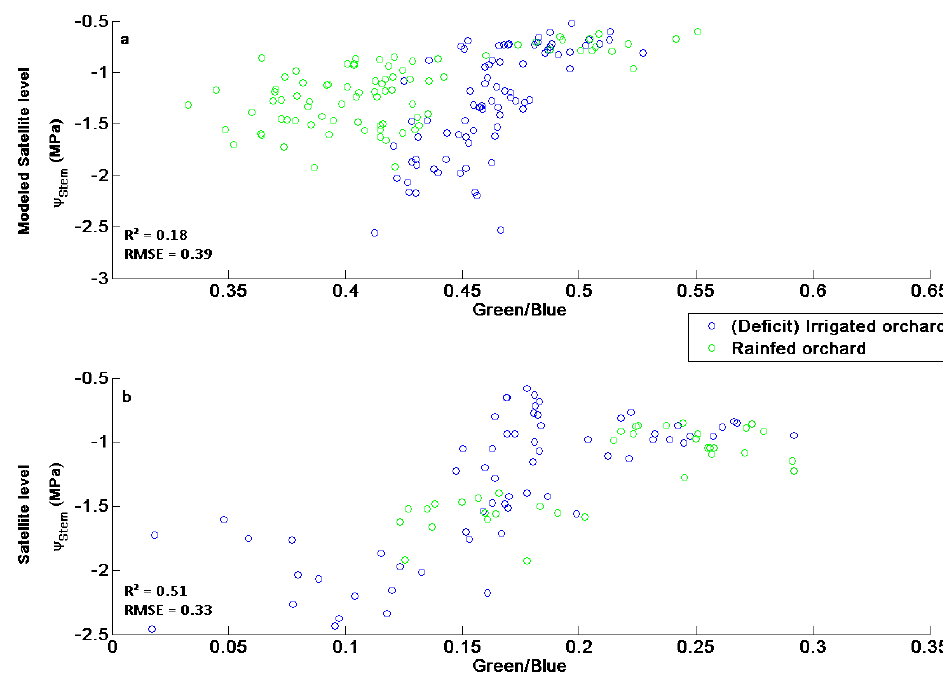
Figure 6. Scatter plot of Normalized Difference Green Blue index (Green/Blue; Equation (6)) with measured stem water potential ( Ψ ; MPa) for the modeled satellite level ( a ) and stem the satellite level ( b ). All points were labeled for